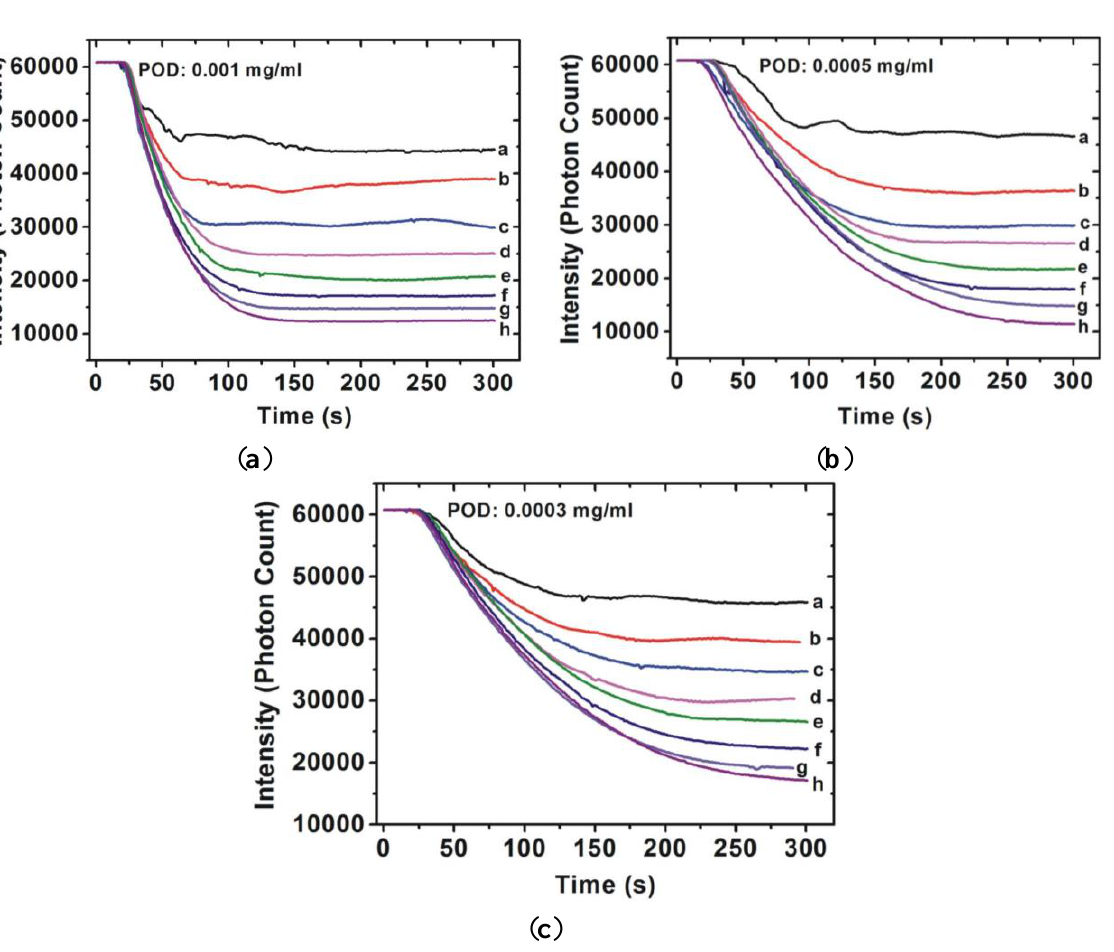
Figure 3. Transmittance-time response behavior of various H 2 O 2 concentrations (a: 0.0001%; b: 0.00015%; c: 0.0002%; d: 0.00025; e: 0.0003%; f: 0.00035; g: 0.0004; h: 0.00045%) measured by the sensor with various POD concentrations (( a ) 0.001 mg/mL; ( b ) 0.0005 mg/mL; and ( c ) 0.0003 mg/mL) at monitored wavelengths of 510